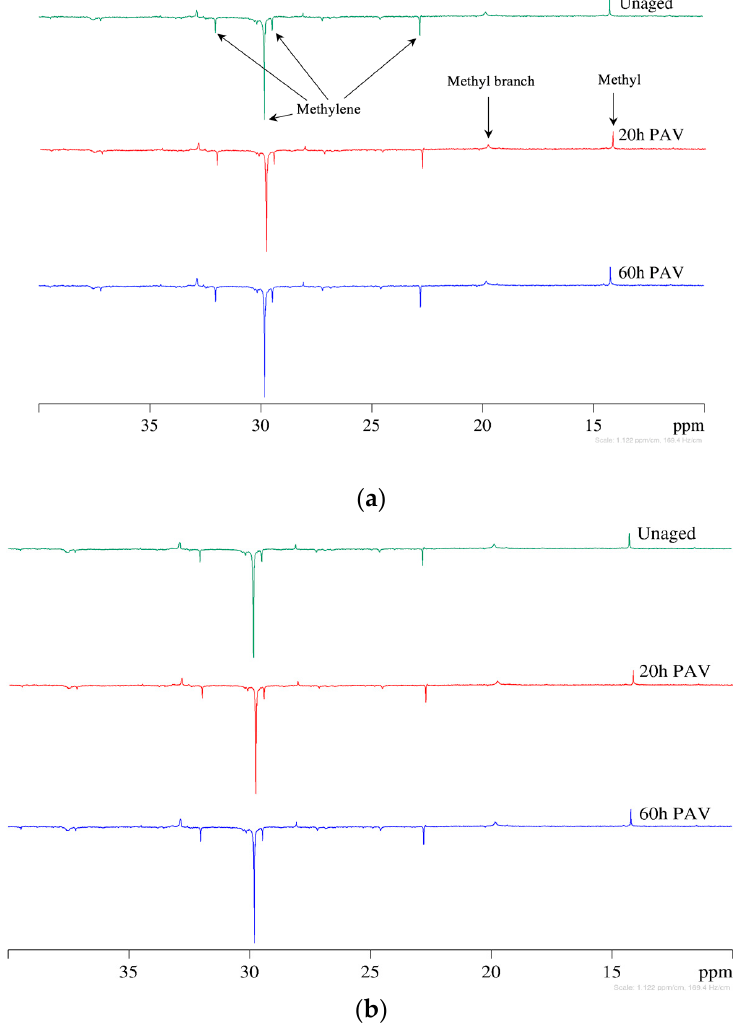
Figure 4. DEPT135 spectra of selected asphalt binders. ( a ) AAV. ( b ) AAC-1.